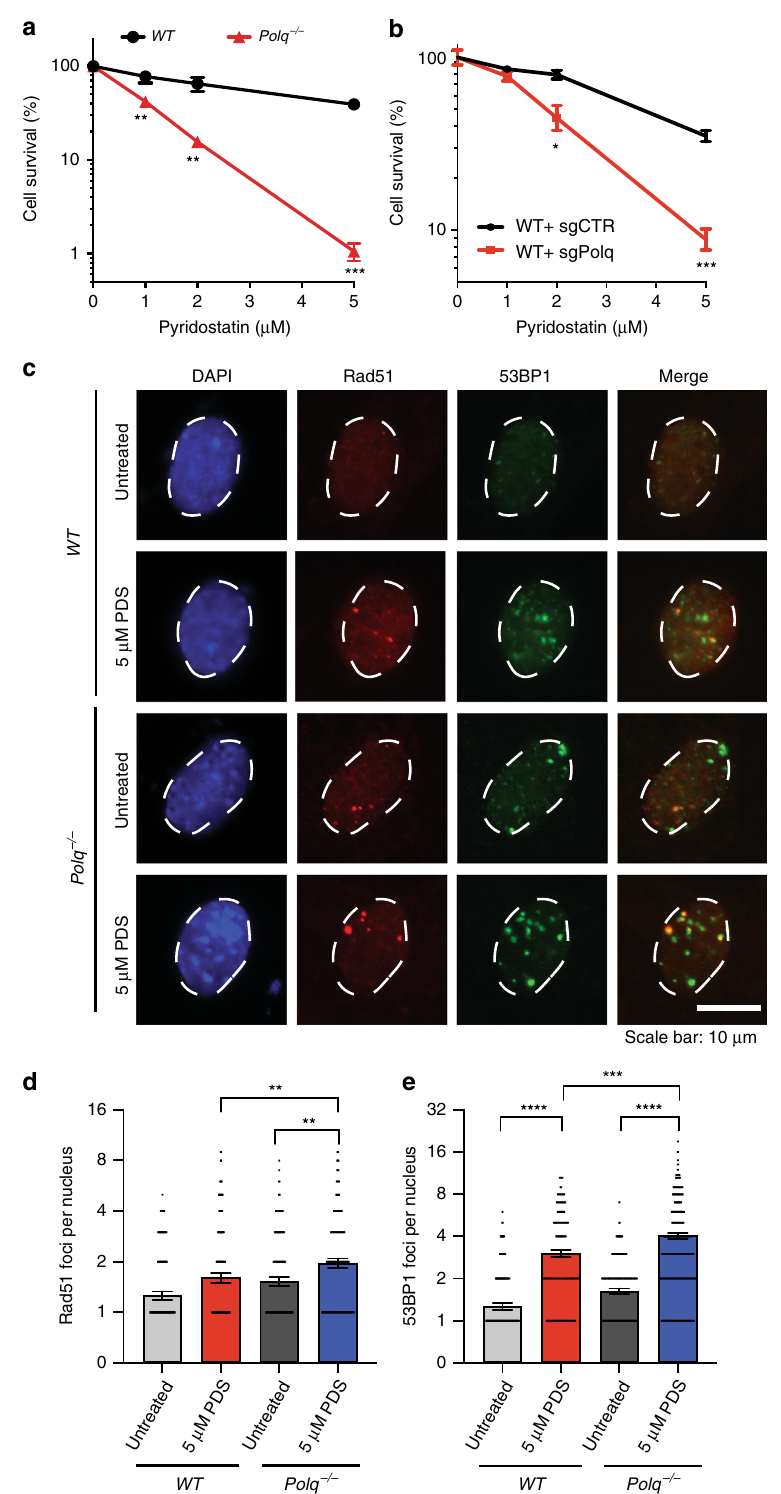
Fig. 5 Polq is required for Pyridostatin induced DNA damage repair. a Colony forming ef fi ciency after treatment with Pyridostatin (PDS, 1, 2, 5 µ M) in WT and Polq − / − MEFs. b Colony forming ef fi ciency after treatment with Pyridostatin (PDS, 1, 2, 5 µ M) in WT MEFs transduced with Cas9 and either sgCtrl or sgPolq (targeting the polymerase domain). a , b Data shown are the mean ± SEM ( n = 3). Statistical signi fi cance was assessed by two-tailed t -tests. * p < 0.05, ** p < 0.01 and *** p < 0.001. c IF images for DAPI (blue), Rad51 (red) and 53BP1 (green) in WT and Polq − / − MEFs six hours after treatment with 5 µ M PDS ( n = 3 biologically independent experiments). d , e are quanti fi cation of large Rad51 and 53BP1 foci, as observed in ( c ). Shown are mean ± SEM, and representative of three independent experimental replicates. Statistical signi fi cance was assessed by Mann – Whitney tests. ** p < 0.01, *** p < 0.001, and **** p <